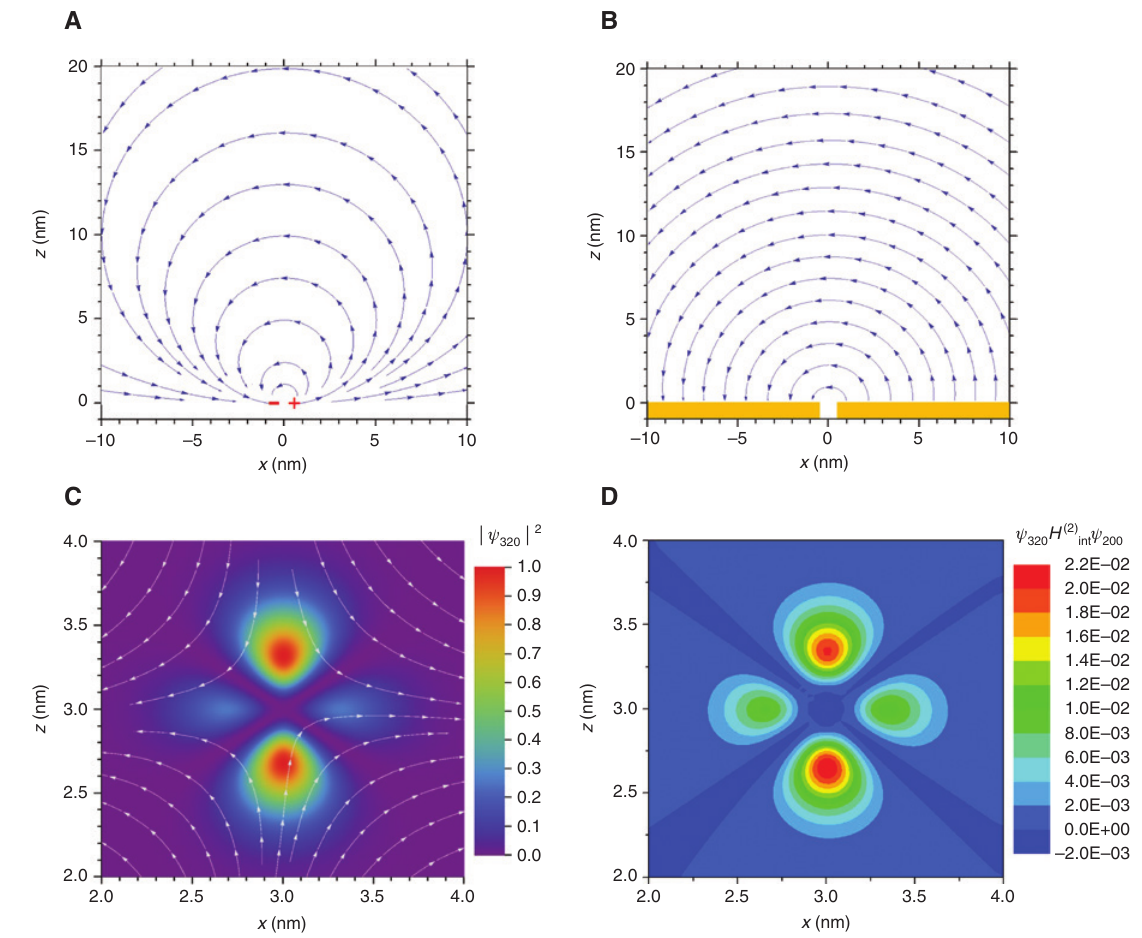
Figure 1: (A) Electric field lines above a line dipole of gap width 1 nm. Line charges are located at x = ± 0.5 nm, z = 0. (B) Electric field profile obtained by an integration of the line dipoles from z = −100 to 0 nm, well fitted with an analytical form from the gap. (C) Electric field lines − scale is in arbitrary units and we use the integrated field profile of Eq. (2). (D) Contour plot of an xz cross section of the overlap integrand ψ ψ (2) H around the center position of ( x 320 int 200